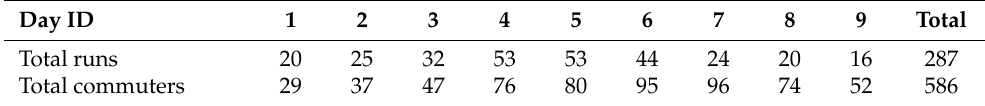
Table 1. Number of runs and number of commuters.